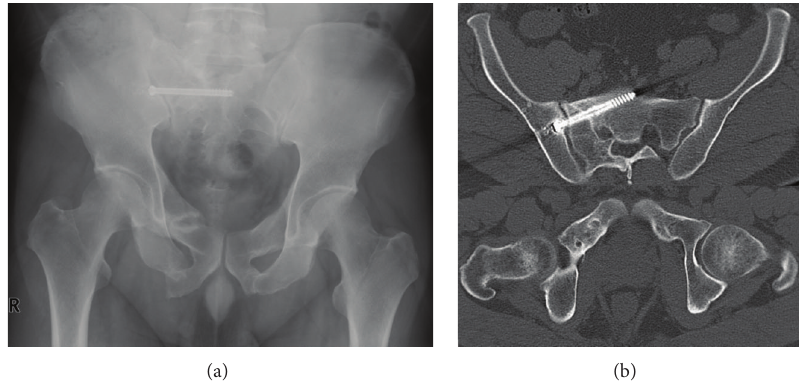
Figure 4: Anteroposterior radiograph (a) and (b) CT images taken 9 months after operation, which demonstrate the healing of nonunion of the right sacrum bone and bilateral superior pubic